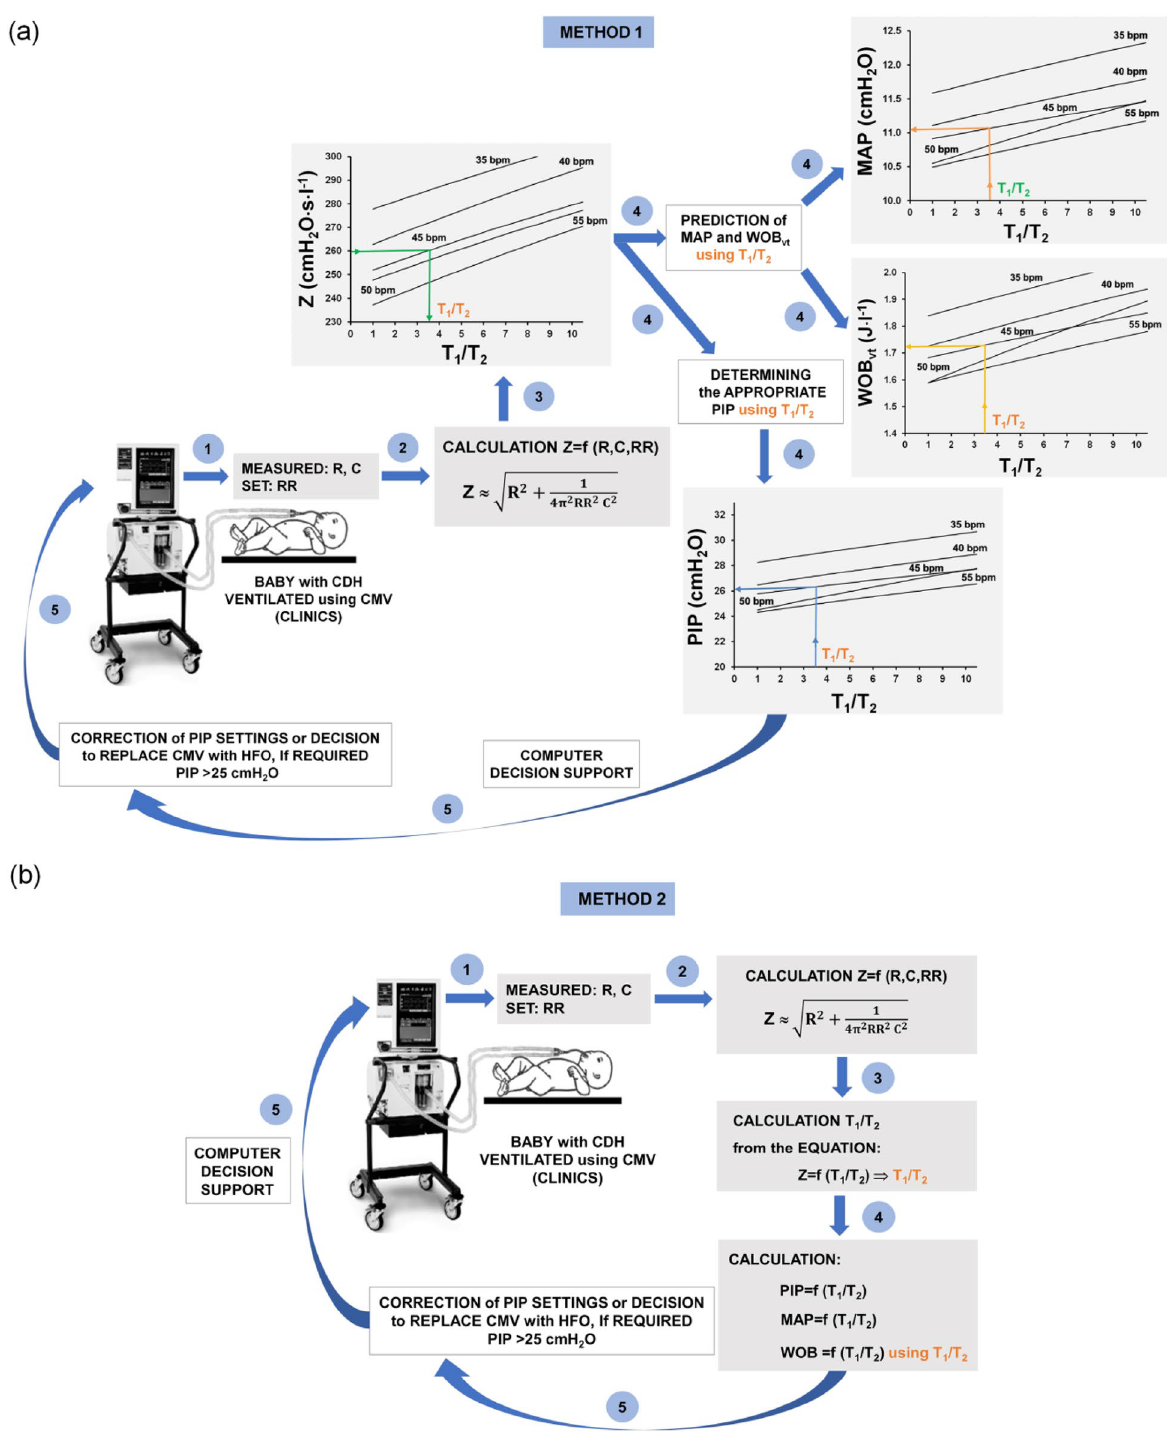
Figure 6. Examples of clinical application of the VI assessment using T 1 /T 2 index to correct settings of PIP at PCV mode of conventional mechanical ventilation (CMV): method 1 ( a) , method 2 ( b ). Inertance (L) was abandoned in the calculation of impedance (step 2) for simplicity; its significance is low at RR < 60 bpm (< 1 central and peripheral airways (C w /C L , R c /R). Clinical data on the topic are hardly available in the literature 32,33 . Based on our study results, we hypothesize that in CDH infants, before hernia repair, the chest wall is stiffer than in healthy infants. It means that the C w /C L ratio may be lower than it has been believed, so far. Further studies are necessary to prove actual C w /C L relation, to explain the reasons for decreased compliance C after hernia repair and to move the research from the simulation level to the clinical use.